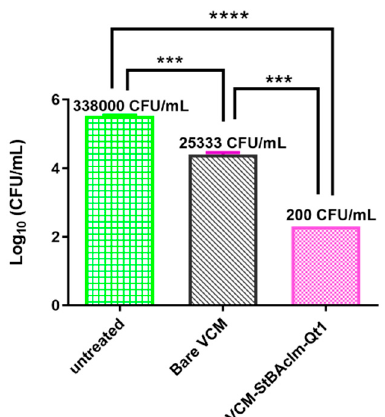
Figure 11. MRSA Log 10 (CFU / mL) evaluation after 48 h of treatment (mean ± SD; n = 3). *** denotes the significant di ff erence between the bare VCM vs. VCM-loaded StBAclm-Qt1 quatsomes and VCM vs. untreated groups. **** denotes the significant di ff erence between VCM-loaded StBAclm-Qt1 quatsomes and the untreated groups.